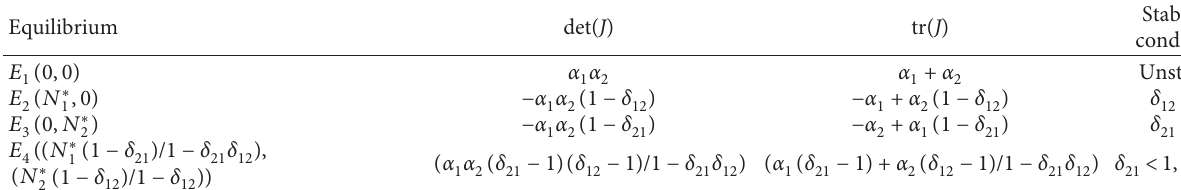
Table 2: Equilibrium and stability condition of SCE.